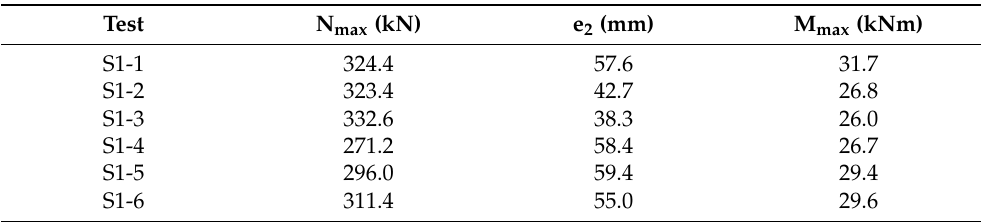
Table 2. Descriptive statistical parameters of the experimental results of the considered test series C45/55 without considering sample size aspects.